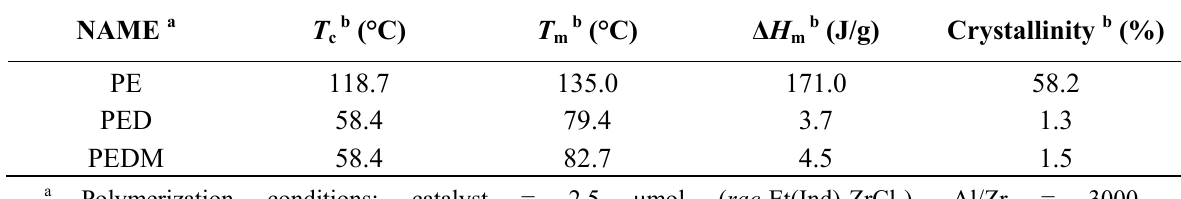
, T , Δ H and crystallinities of PE, PED and m c m